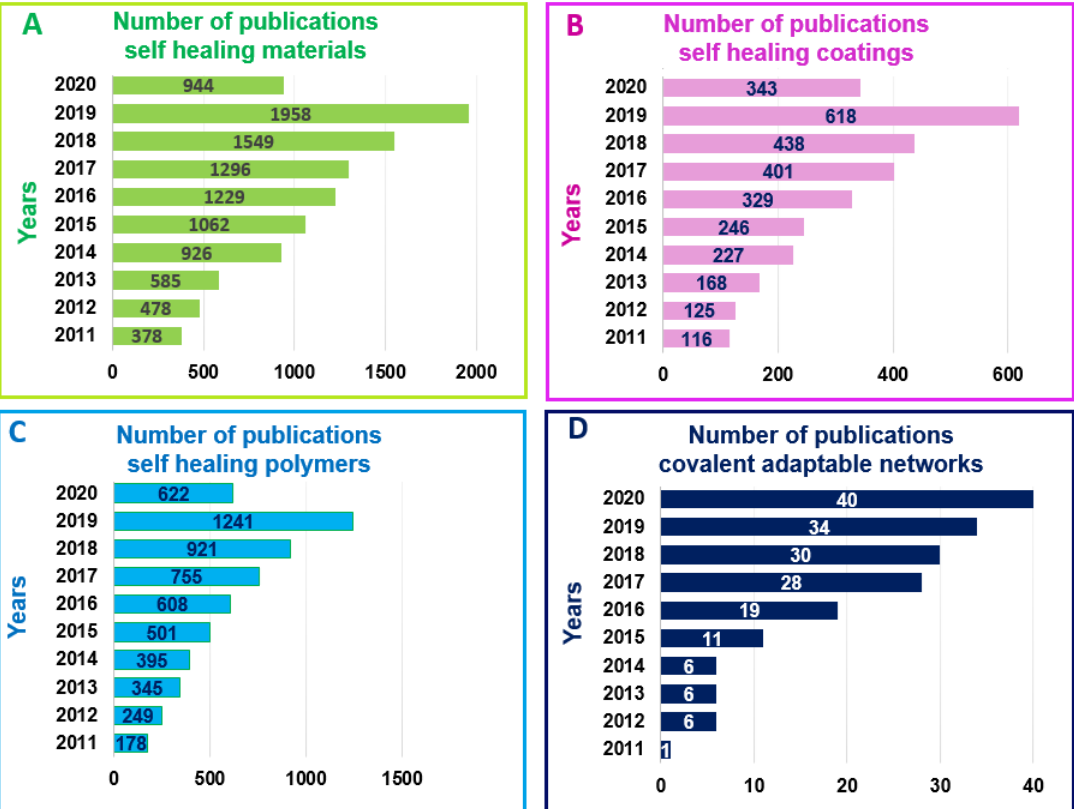
Figure 2. Articles published in the last 10 years related to: ( A ) self-healing materials; ( B ) self-healing coatings; ( C ) self-healing polymers and ( D ) covalent adaptable networks. These numbers were generated from the “Web of Science database” using the keywords “self-healing materials” for ( A ), “self-healing coatings” for ( B ) , “self-healing polymers” for ( C ), and “covalent adaptable networks” for ( D ). (Date data acquired: 15 July 2020).